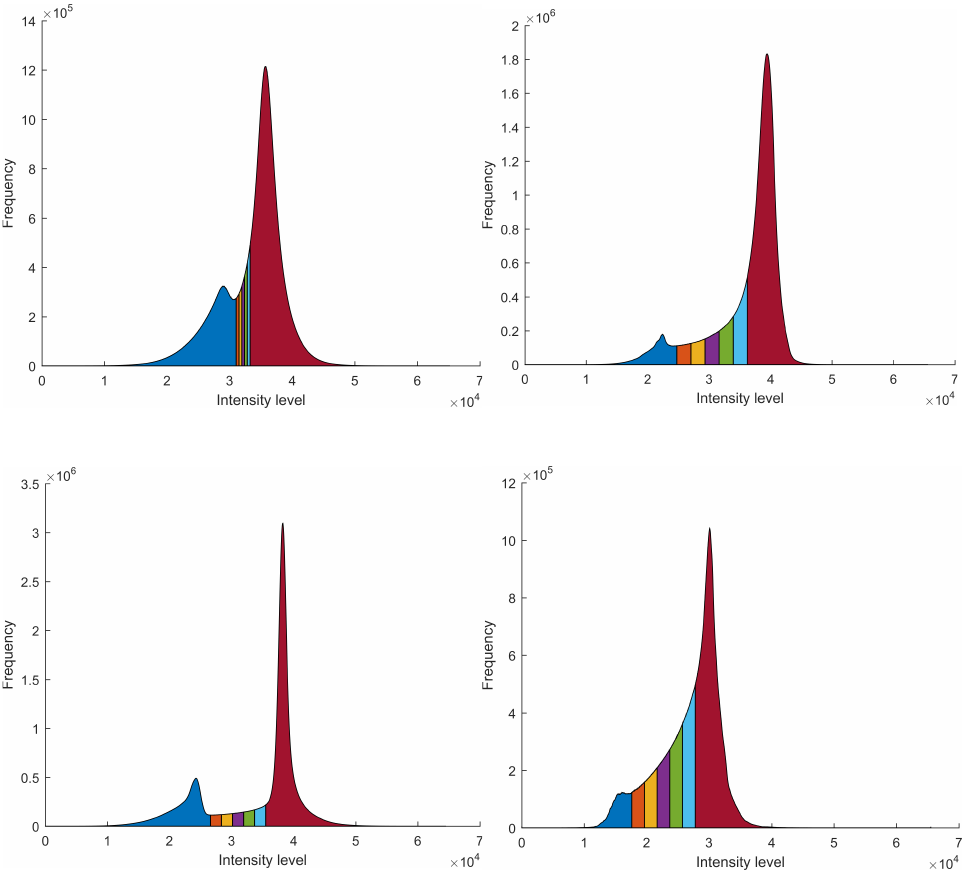
Fig 5.: Color-coded histograms of the scanned samples. Top row: Carb-A with high (left) and low resolution (right). Bottom row: Carb-B with high (left) and low resolution (right). Between the high-confidence pore phase (marked blue) and the high-confidence mineral phase (marked red) we define five intermediate classes to characterize the micritic phases within carbonate rock.